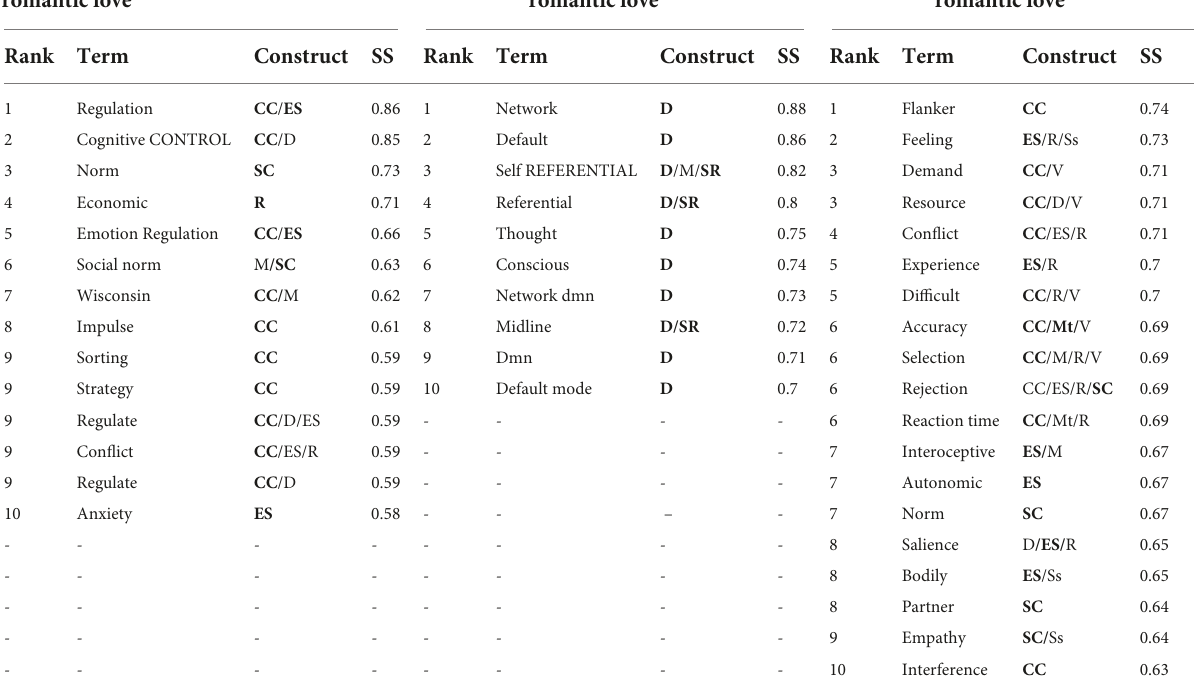
The terms are sorted by order of the similarity score. Bold characters in the construct column represent the most influential mental process constructs. The terms are sorted by the order of the similarity score. SS, Similarity score; D, default mode network-related constructs; CC, cognitive control processing; ES, emotional salience mental processes; M, memory-related